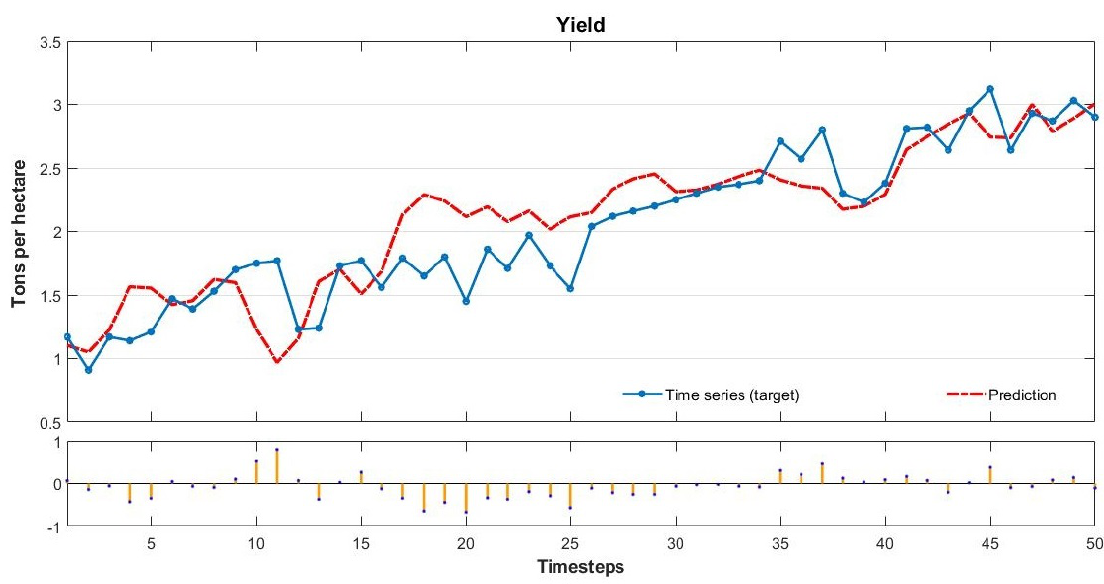
Figure 11. Multistep prediction of yield using Matlab